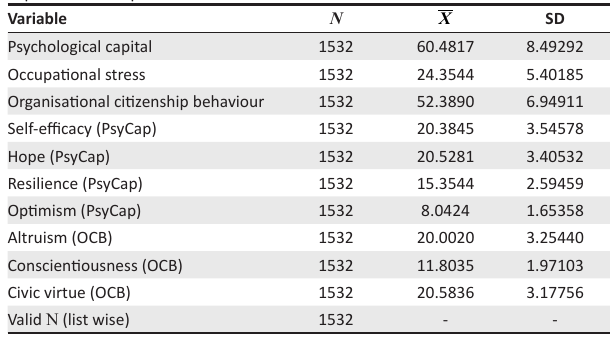
TABLE 1: Descriptive analysis showing the mean and standard deviation among organisational citizenship behaviour, the three dimensions of organisational citizenship behaviour, psychological capital, the four dimensions of psychological capital and occupational